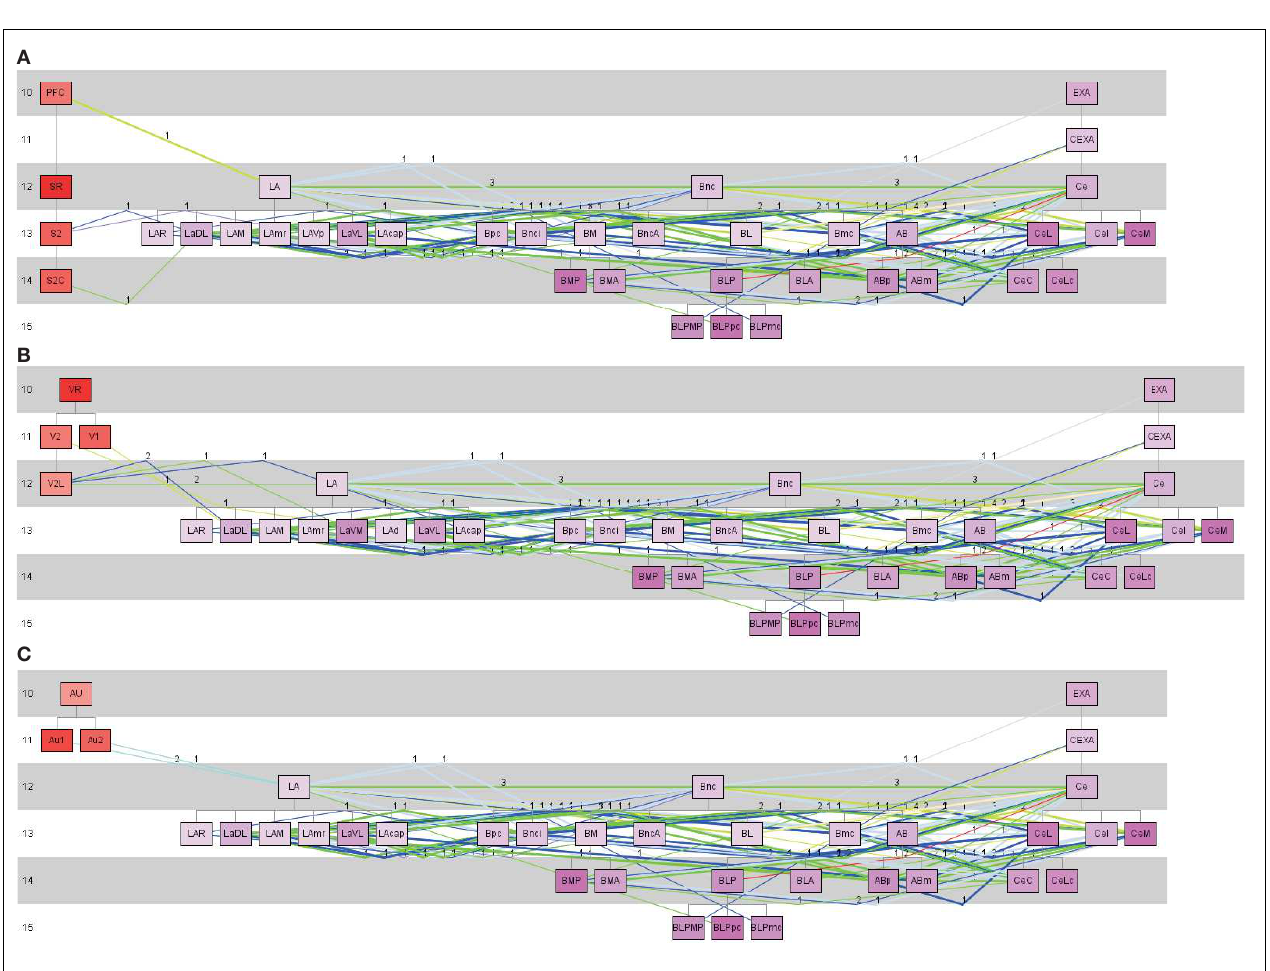
connections were chosen which project to CE subregions.The colors of lines corresponds to the weight code in Figure 4 .Thick lines indicate reciprocal connections and the numbers indicate the number of studies that have documented a particular connection. In the left part are the source regions displayed, then the LA subtree regions are following, then the basal nuclear complex subtree regions, and on the right the subregions of the CE subtree.The numbers at the left part of the pathway-diagrams are indicating hierarchical levels.